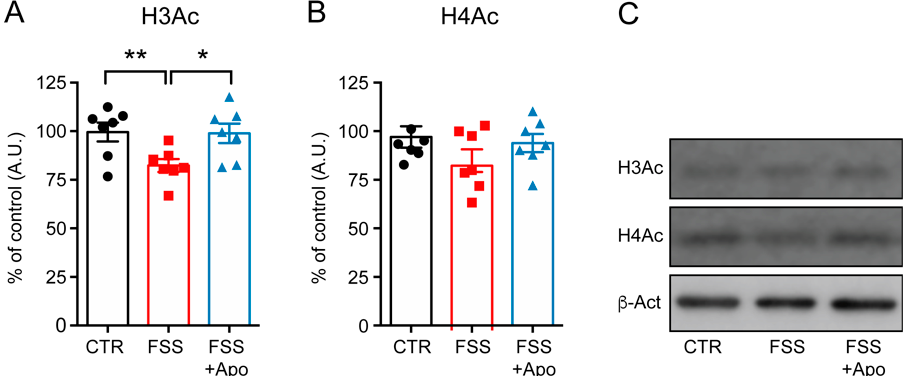
Figure 5. Apocynin prevents the FSS-induced reduction of H3 acetylation. ( A,B ) Levels of acetylated histone H3 (H3Ac) ( A ) and acetylated histone H4 (H4Ac) ( B ) measured in the hippocampus. Densitometric quantification were obtained as ratio of H3Ac/Actin and H4Ac/Actin. One-way ANOVA followed by Tukey’s post hoc analysis. Data are presented as mean ± SEM ( n = 10–11 mice/group). ( C ) Representative Western blot images from H3Ac, H4Ac, and b-actin. * p < 0.05; ** p < 0.01.